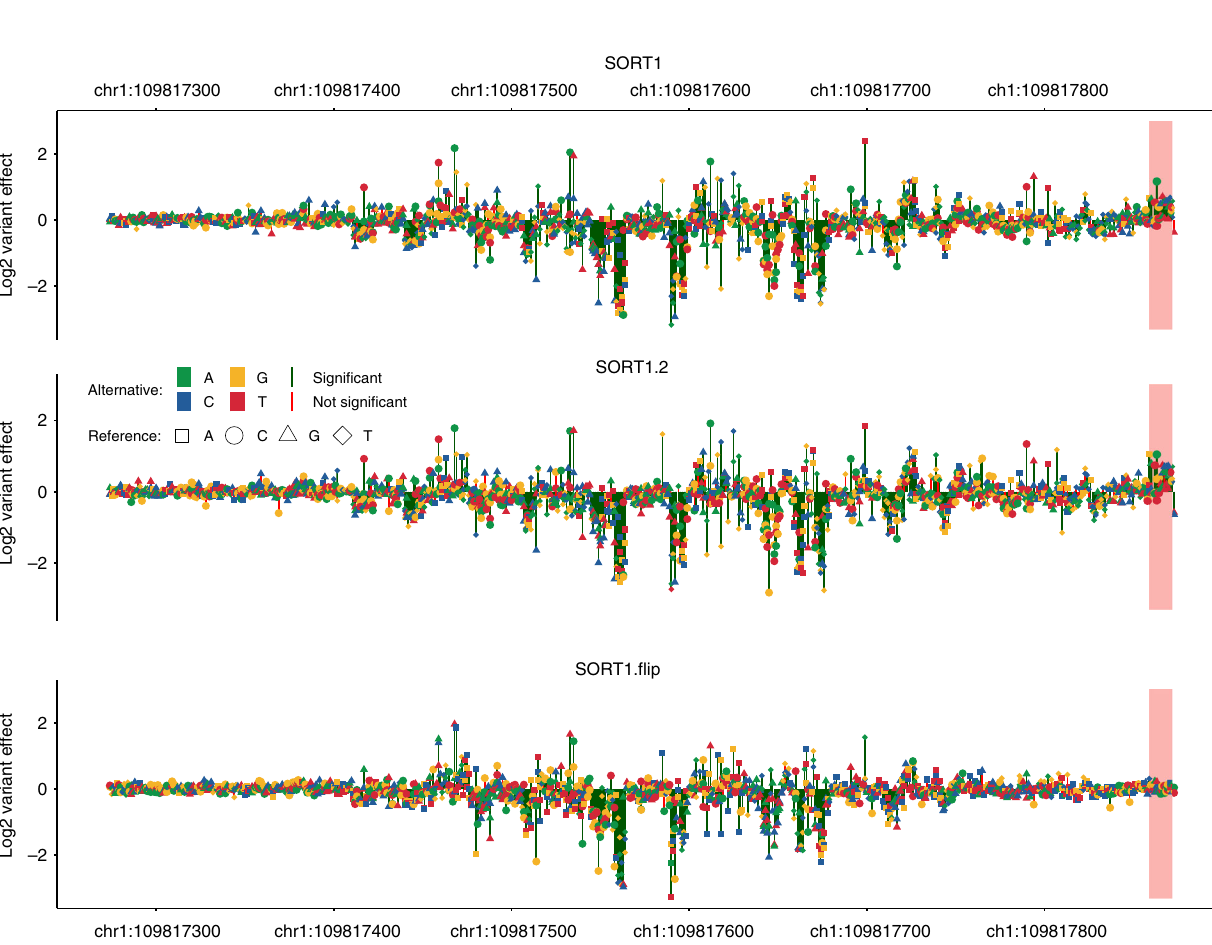
Fig. 3 Saturation mutagenesis MPRA of a myocardial infarction-associated SORT1 enhancer. Expression effects of SNVs from experiments SORT1, SORT1.2, and SORT1. fl ip. Direction of SORT1 and SORT1.2 was from left to right in the experiments. In the SORT1. fl ip experiment, the direction was reversed (right to left in the fi gure). Highlighted area in red, close to the experimental promoter site in SORT1 and SORT1.2, is different between the SORT1/SORT1.2 and SORT1. fl ip experiments. In this region, JASPAR annotates an EBF1 motif (MA0154.3). A signi fi cance threshold of 10 − 5 was used (red vs. green vertical